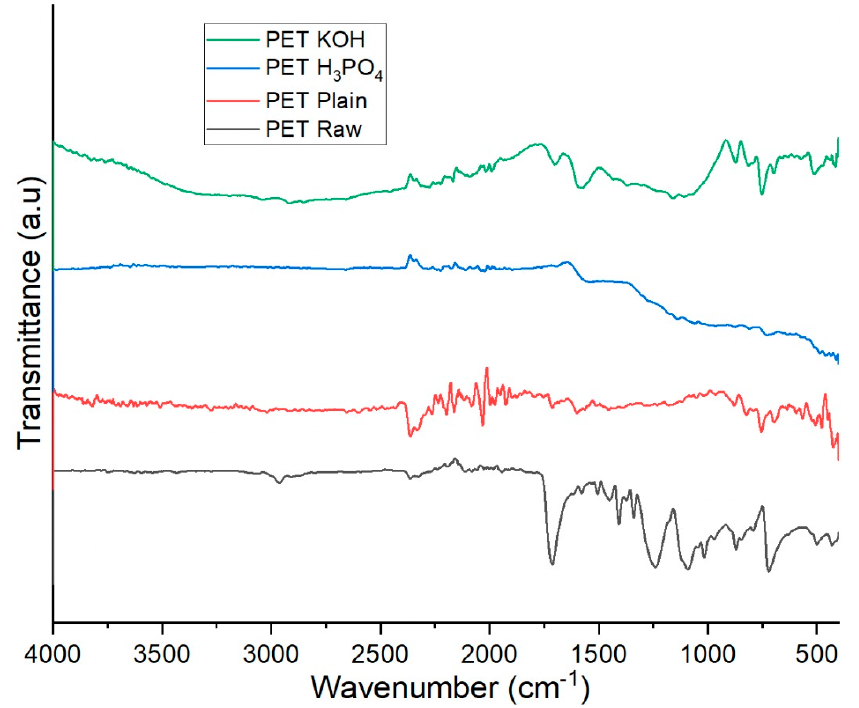
3 PO 4 and PET KOH.